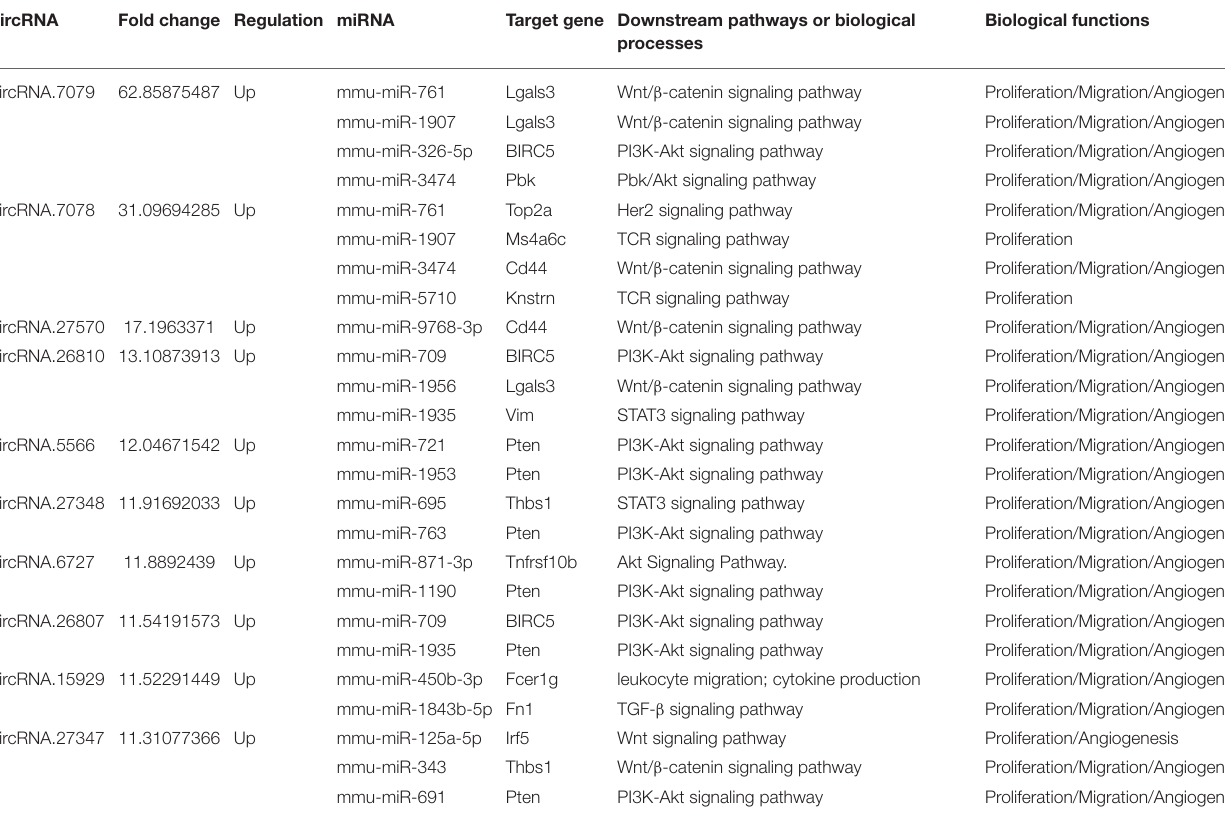
TABLE 3 | The top 10 differentially expressed CircRNAs involved in vascular endothelial proliferation, migration, and angiogenesis after SCI.